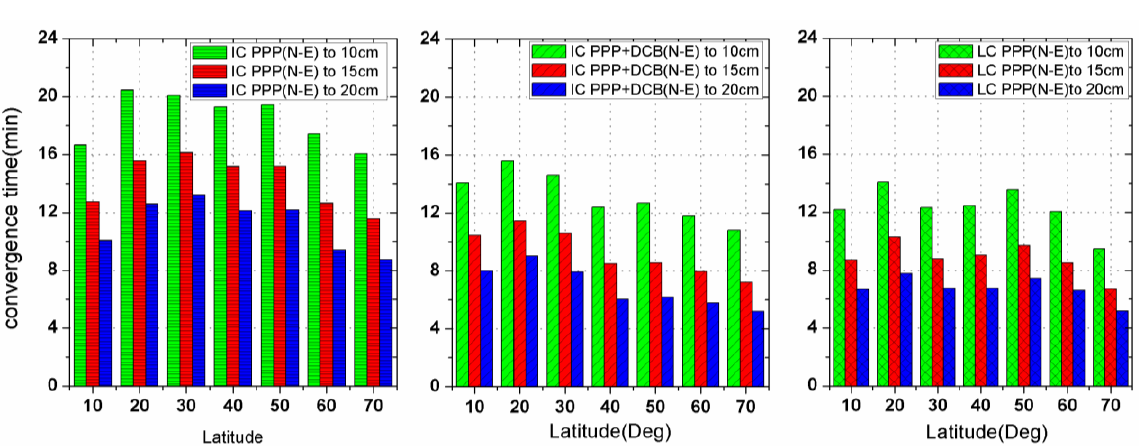
Figure 5. Convergence time for different latitude zones for the three processing scenarios IC-PPP ( Left ), IC-PPP+DCB ( Middle ) and LC-PPP ( Right ). On each sub-plot the convergence green, red and blue bars are for time converged to 10cm, 15cm and 20cm,